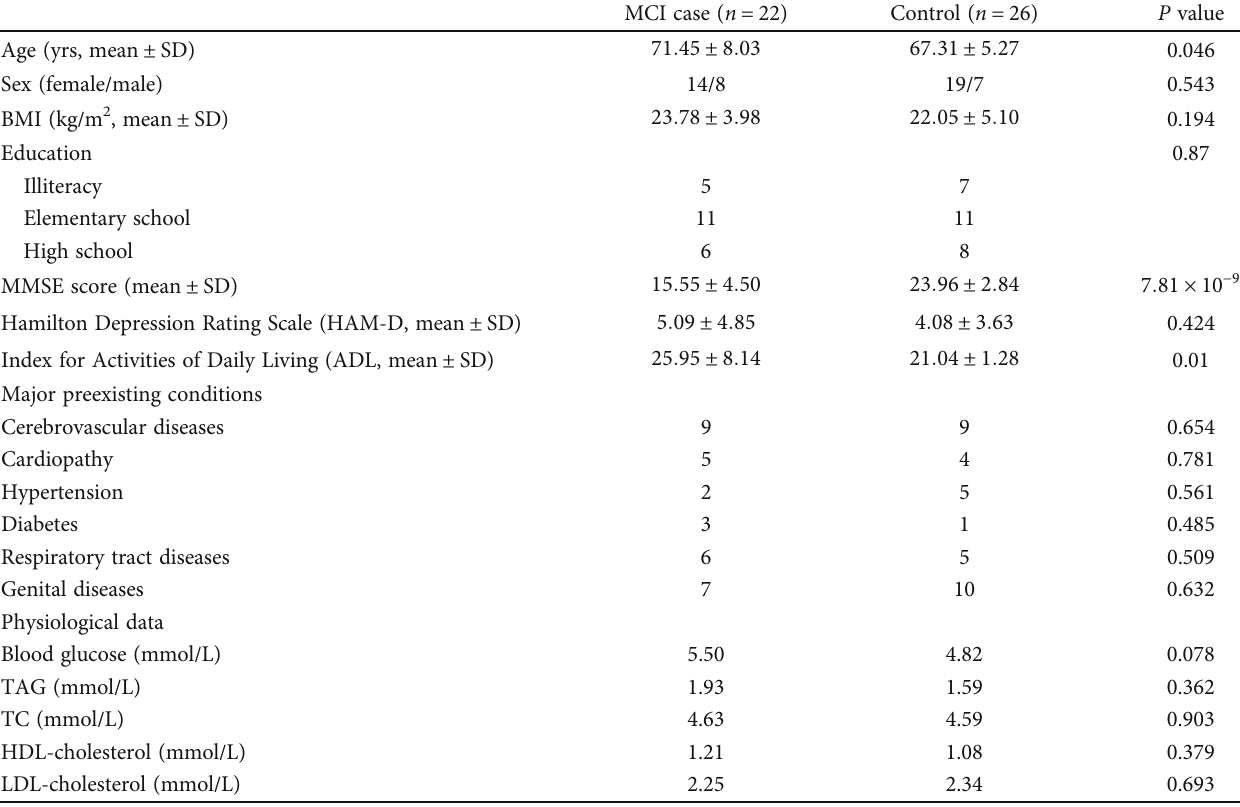
Table 1: Baseline characteristics of study subjects.